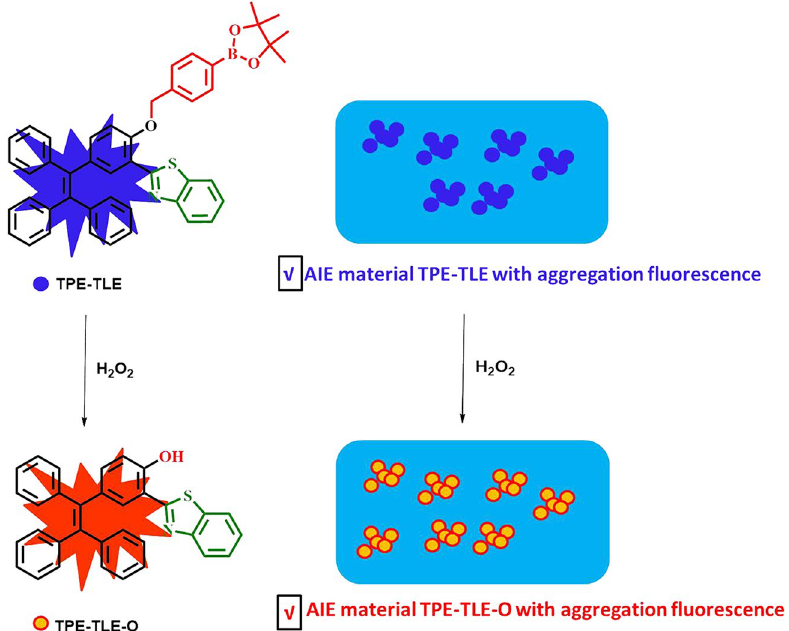
Figure 1. The sense mechanism of the probe TPE-TLE to H 2 O 2.